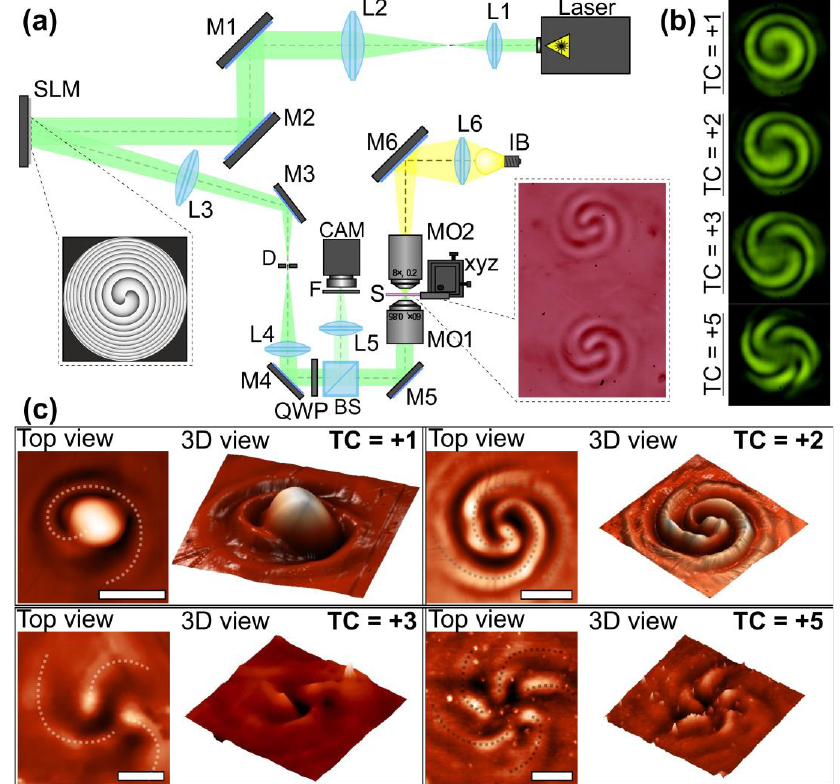
Figure 3. Multi-spiral laser patterning of azopolymer thin films. ( a ) Experimental setup for laser patterning of azopolymer thin films. Laser is a solid-state laser ( λ = 532 nm, P out = 20 mW); L1, L2, L3, L4, L5, and L6 are spherical lenses ( f 1 = 25 mm, f 2 = 150 mm, f 3 = 500 mm, f 4 = 400 mm, f 5 = 150 mm, and f 6 = 50 mm); M1, M2, M3, M4, M5, and M6 are mirrors; SLM is a reflective spatial light modulator (HOLOEYE PLUTO VIS, 1920 × 1080 pixels, pixel size of 8 μm); BS is a beam splitter; MO1 and MO2 are microobjectives (NA = 0.4 and 0.1); S is a glass substrate with an azopolymer thin film that was mounted on the 3-axis XYZ translation stage; IB is a light bulb; F is a neutral density filter; CAM is a video camera (TOUPCAM UHCCD00800KPA; 1600 × 1200 pixels with a pixel size of 3.34 μm) ; and QWP is a quarter wave plate. The inset on the left side shows a phase of the element generating an OV beam with a TC of 2. The inset on the right side shows an optical microscopy image of the surface of an azopolymer thin film patterned with this OV beam. ( b ) Experimentally obtained multi-spiral interference patterns formed with the described experimental setup in the case of different OV beams. ( c ) Images of the profiles of the microstructures fabricated with circularly polarized radiation and measured with a scanning probe microscope. Four different microstructures fabricated using OV beams with TCs +1, +2, +3, and +5 are shown. The dotted curves indicate the formed spirals. The scale bar is 10 µm.